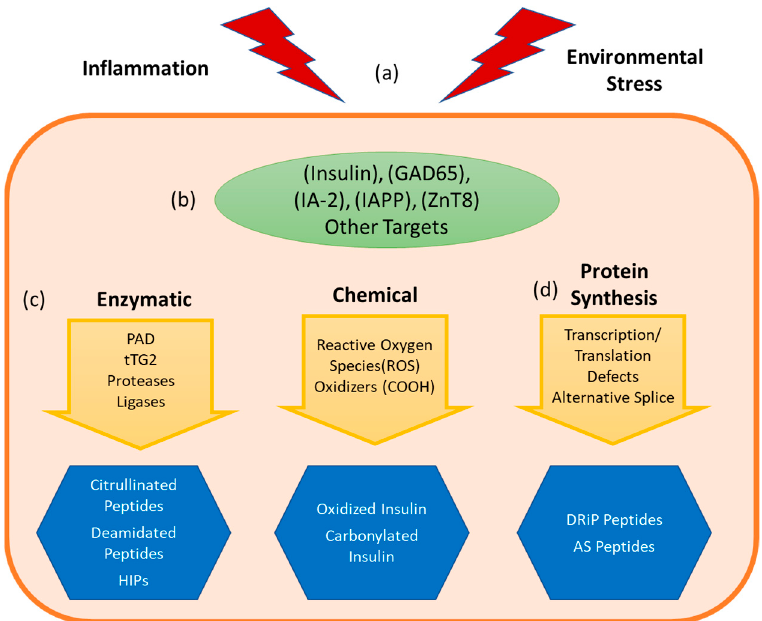
Figure 2. Formation of neo-antigens and epitopes. An undetermined stress event ( a ) combines with the beta cell’s unique metabolism and vulnerability to cellular and environmental stresses, leading to a cascade of deleterious events. Consequently, tissue specific proteins ( b ) are altered, leading to the formation of immunogenic neoepitopes ( c ) via enzymatic catalyzed pathways such as citrullination and deamidation, or biochemical reformation of reactive sidechains by processes such as oxidation. ( d ) Neoepitopes can also arise due to events during transcription and translation, producing alternatively spliced (AS) peptide junctions or defective ribosomal products (DRiPs). These neoepitopes can be presented by antigen presenting cells (APCs) resulting in autoreactive T cell responses.